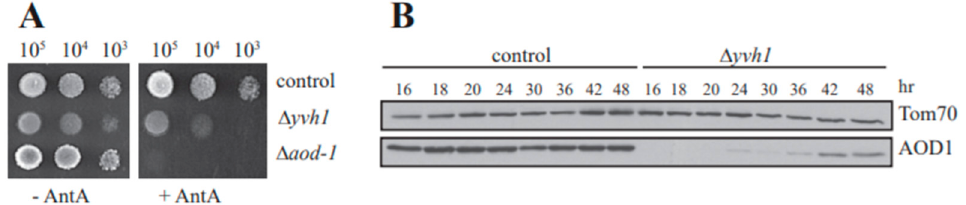
Figure 1. Growth of Δ yvh1 cells and induction of AOD1. ( A ) Growth rate of Δ yvh1 . Ten fold serial dilutions of conidia (numbers indicated at top of panel) from a wild type positive control strain (NCN251), a negative control strain ( Δ aod-1 ) and Δ yvh1 were spotted onto plates and incubated at 30 ◦ C for 48 h on standard growth medium ( − AntA) and for 68 h on medium containing AntA ( + AntA). ( B ) Western blot analysis for the appearance of AOD1. Mitochondrial fractions were isolated from the control strain (NCN251) and Δ yvh1 after growth in the presence of Cm for the specified times. Proteins were separated by SDS-PAGE, blotted to nitrocellulose membrane and probed with the antibodies indicated on the right. TOM70 [62], an outer mitochondrial membrane protein, was used as a loading control.